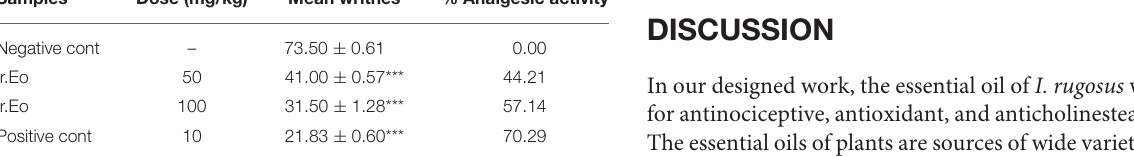
TABLE 2 | Percent anti-nociceptive potential of essential oil following acetic acid induced writhing model. Samples